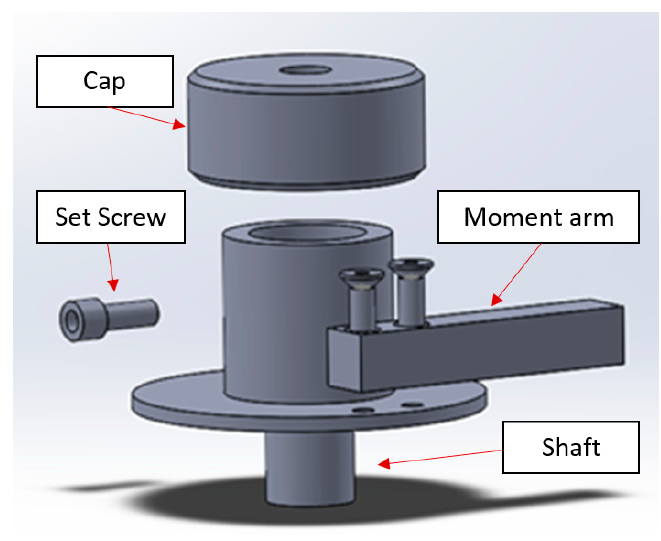
Figure 1. Workpiece holder schematic diagram.